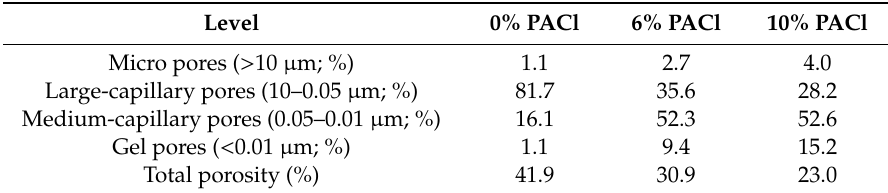
Table 3. Total porosity and pore size analysis.